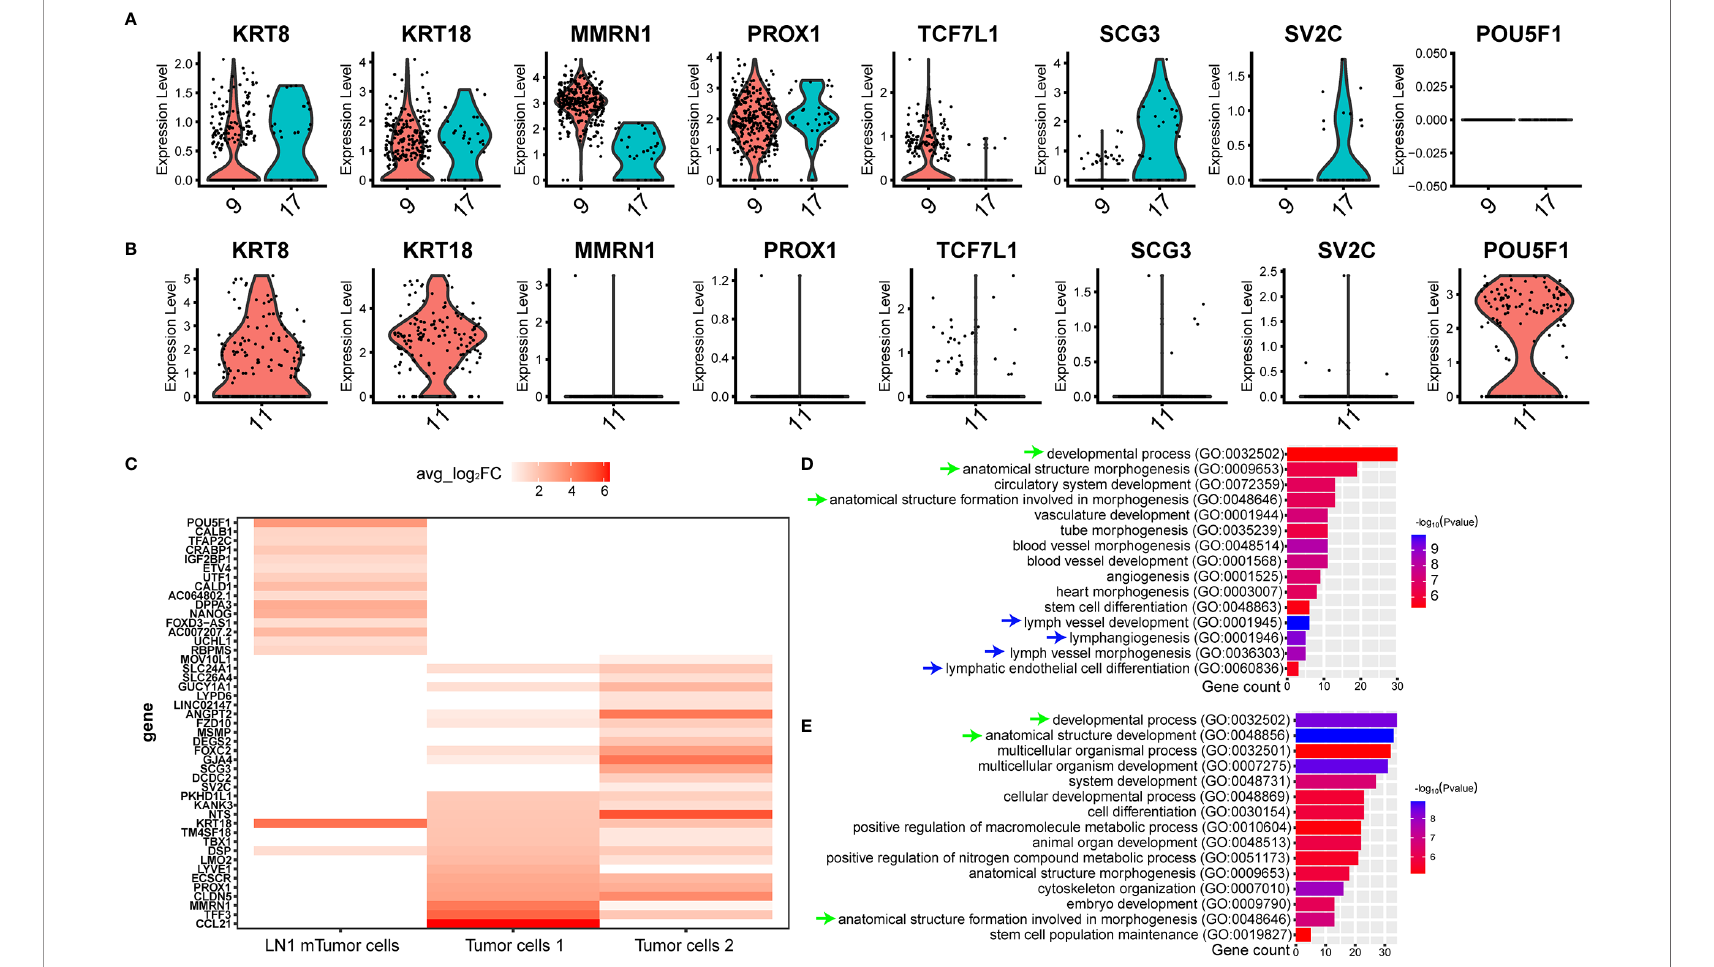
FIGURE 5 | ScRNA-seq revealed the cellular molecular characteristics of testicular seminoma cells. (A) Violin plots showing tumor-speci fi c markers expressed in tumor cell types from testicular tumor. (B) Violin plots showing tumor-speci fi c markers expressed in tumor cells from left pelvic lymph node tumor. (C) Gene expression characteristics of the tumor cells in primary testicular tumor and pelvic lymph node metastasis. (D) GO enrichment analysis of tumor cells 1 in primary testicular tumor. (E) GO enrichment analysis of tumor cells in pelvic lymph node metastasis for biological